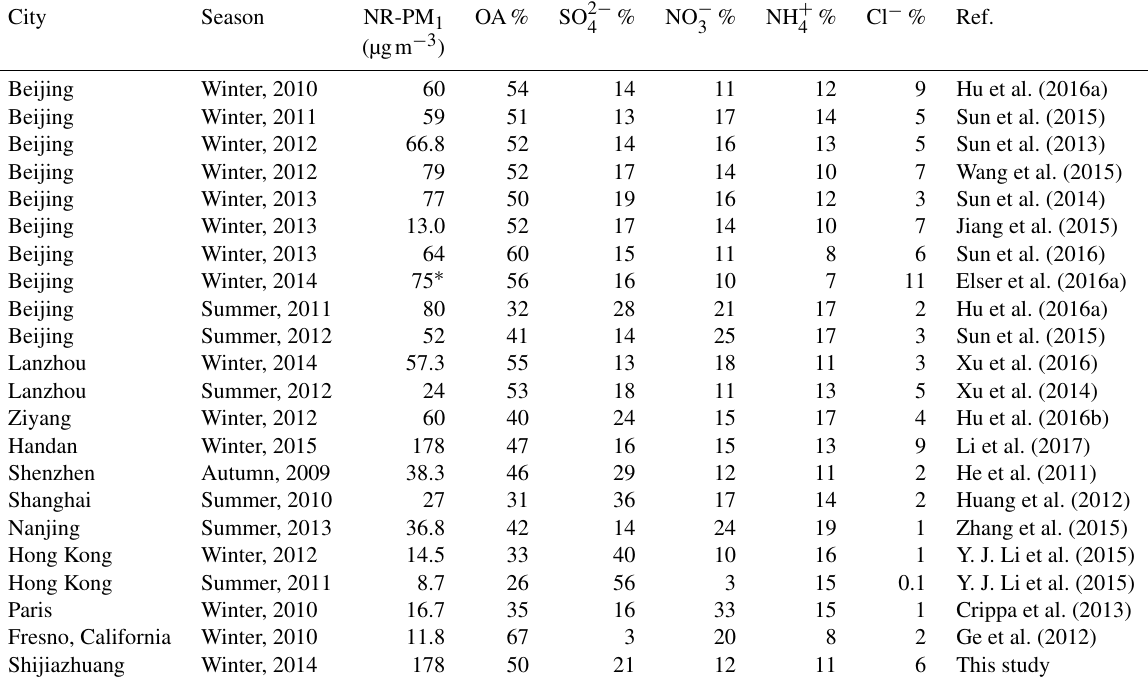
Table 1. The fine PM mass concentrations and fractional contribution of different compositions at different locations.